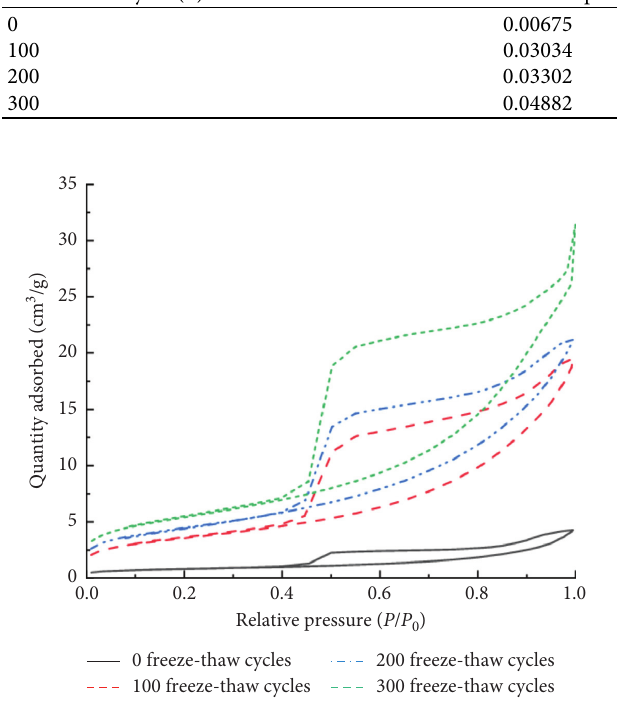
Figure 6: Adsorption/desorption isotherms of the AASC.